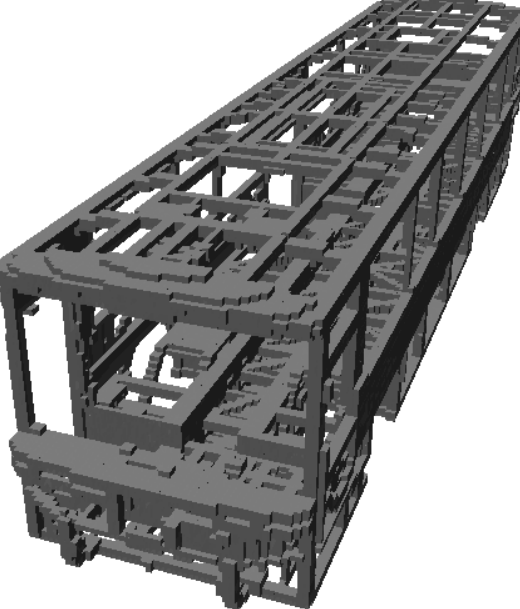
Figure 2. Demonstration of occupancy map constructed from CAD models.